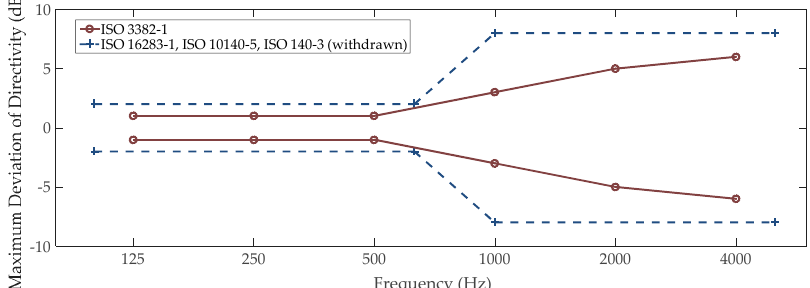
Figure 1. The maximum deviation of directivity of source in decibels for excitation with octave bands of pink noise and measured in free field for ISO 3382-1, ISO 16283-1, ISO 10140-5 and ISO 140-3 (withdrawn).